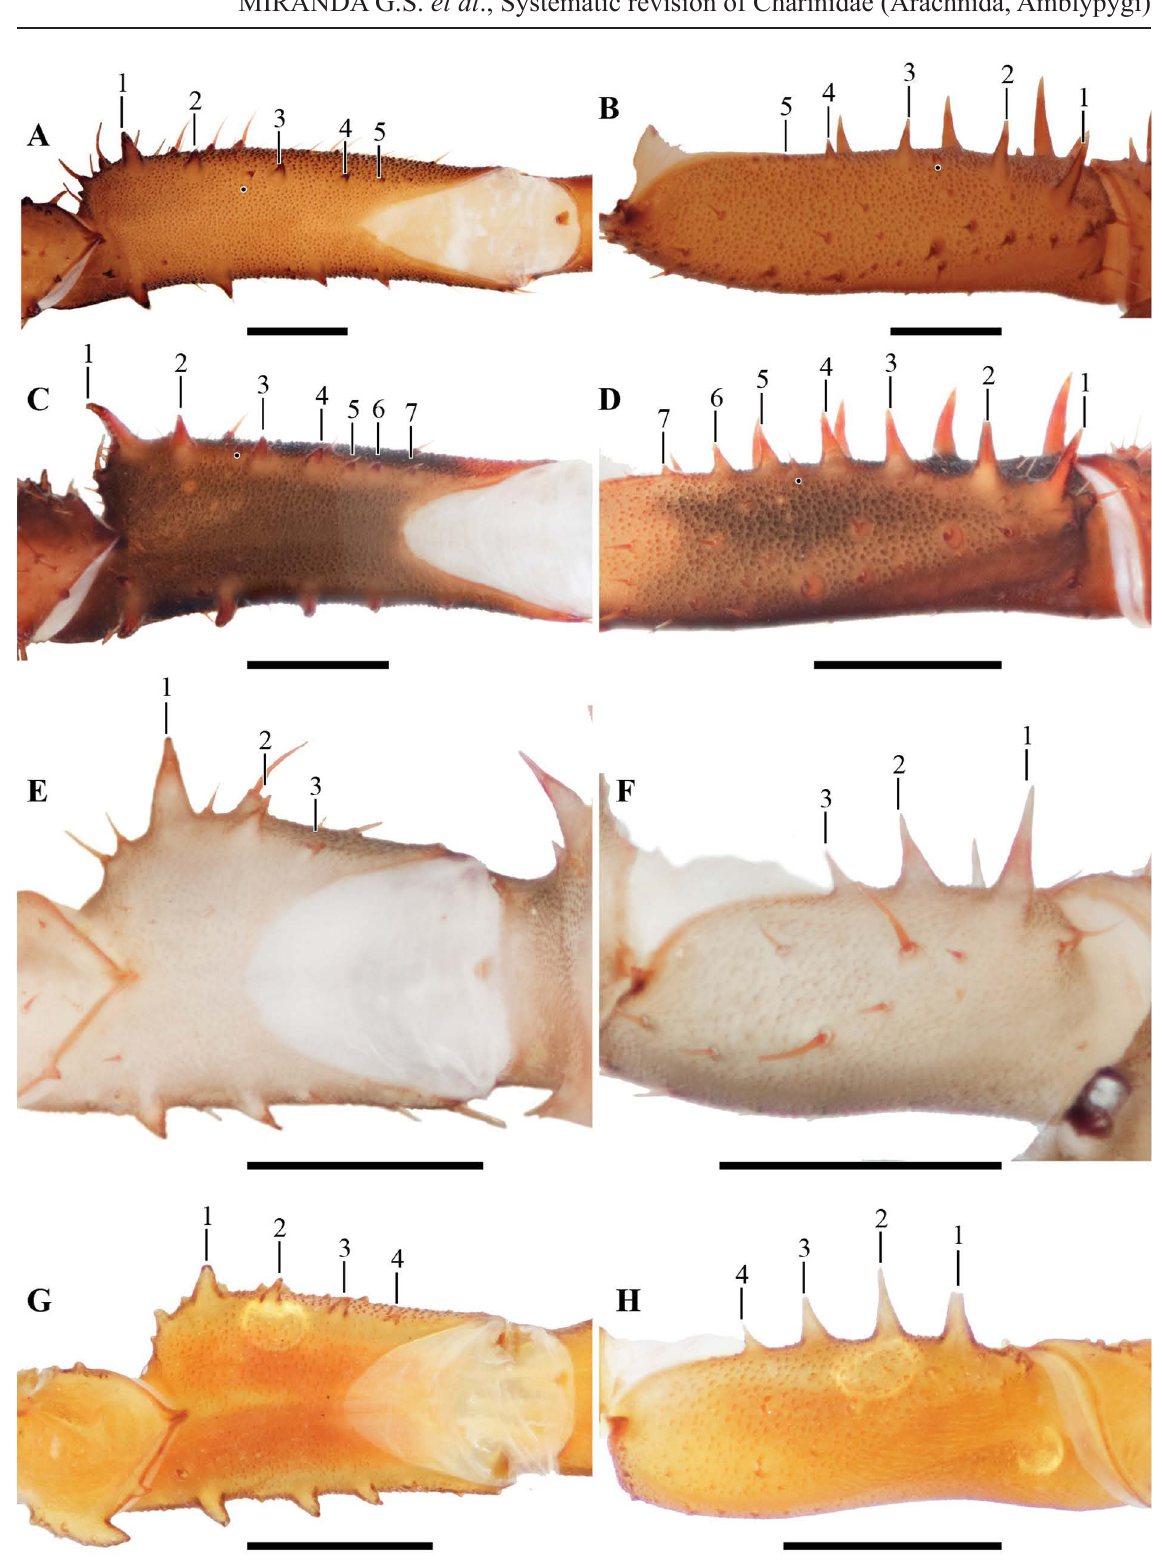
Fig. 3. Charinidae Quintero, 1986, pedipalp femur, prolateral and dorsal views. A–B . Charinus carinae sp. nov. (MNRJ 9293). C–D . Charinus gertschi Goodnight & Goodnight, 1946 (AMCC [LP 10076]). E–F . Sarax bispinosus (Nair, 1934) (AMCC [LP 12298]). G–H . Sarax willeyi Gravely, 1915 (SMF). Scale bars: A–D, G–H = 1 mm; E–F =